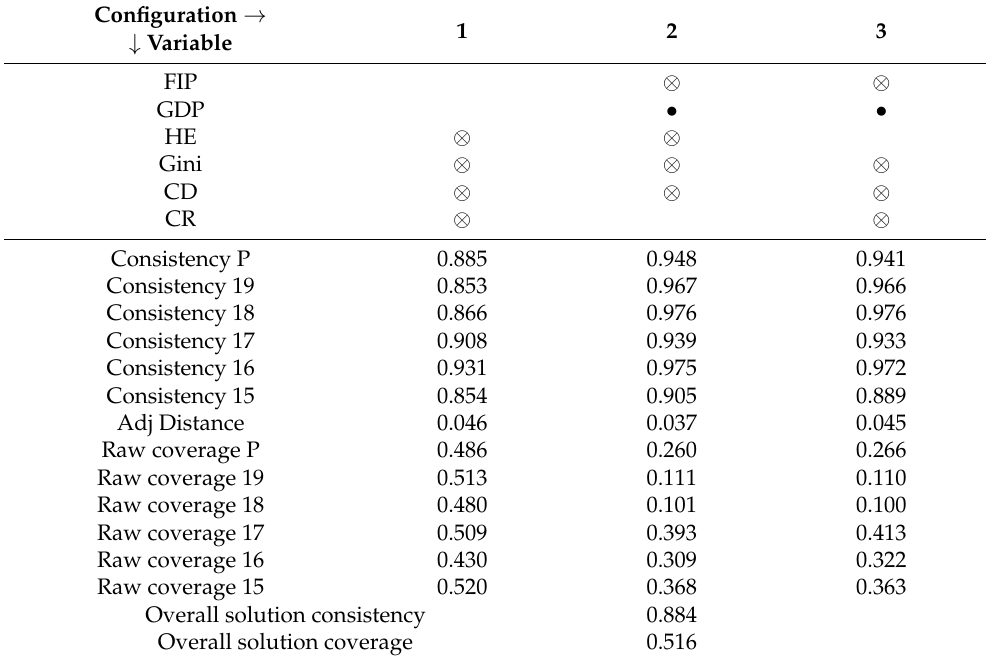
Table 6. Configurations for low energy consumption efficiency performance. Configuration → 1